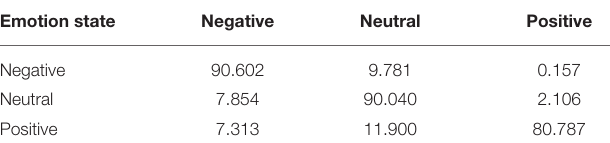
TABLE 5 | Posture emotion recognition confusion matrix during healthcare lecture or electives in medical college.